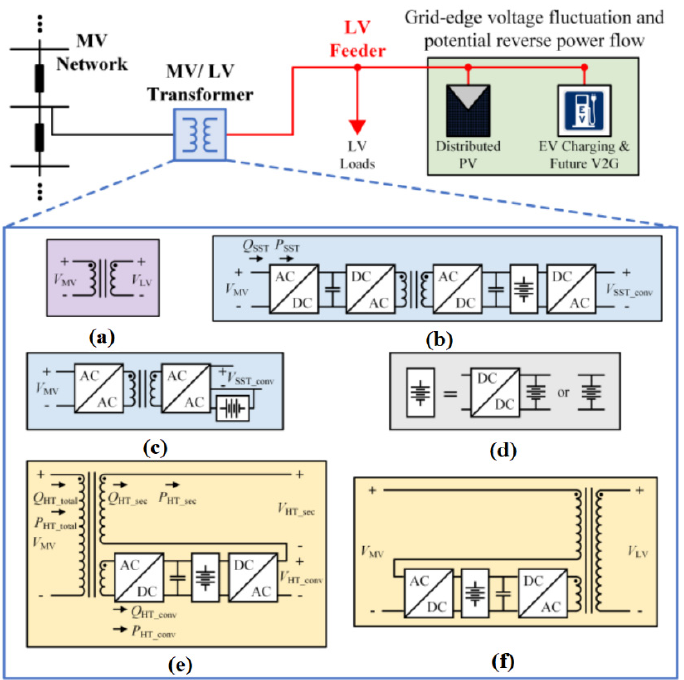
Figure 3. Solid state transformer (SST) and the hybrid transformer (HT) with integrated storage in active distribution grids [19]. ( a ) Line frequency transformer. ( b , c ) SST. Both the three stage SST in ( b ) and the single stage current source SST in ( c ) can realize controllability and storage integration. ( d ) Energy storage. ( e , f ) HT. The converter in the HT can be installed either on ( e ) LV side or ( f ) MV side of the transformer.